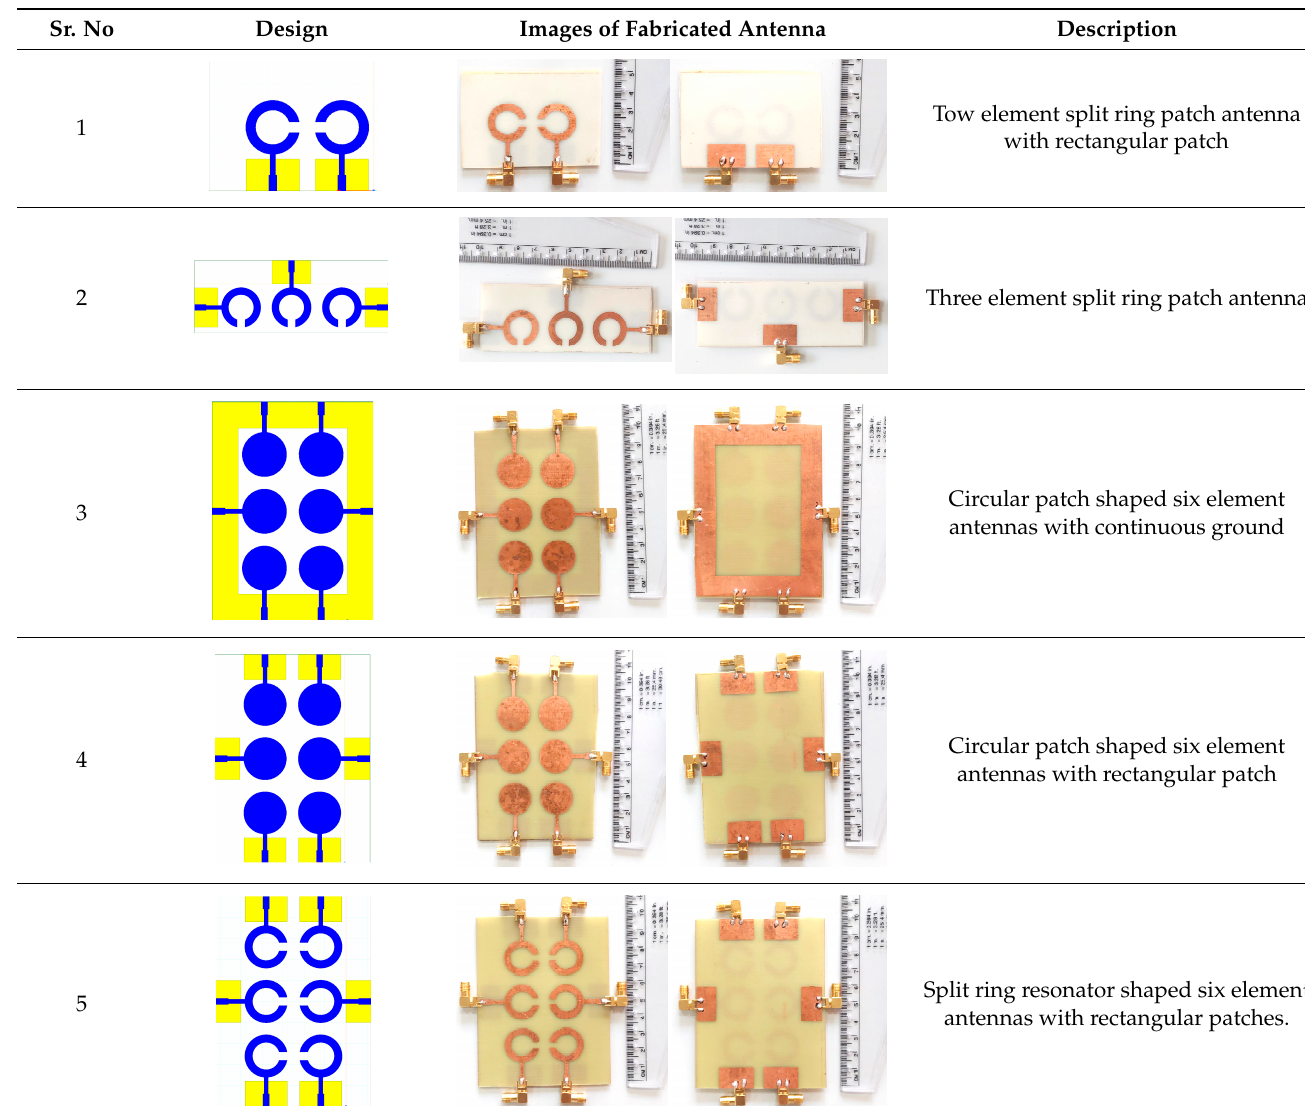
Table 2. Different split rings and circular patches shaped the proposed antenna with its fabricated images and its description of the